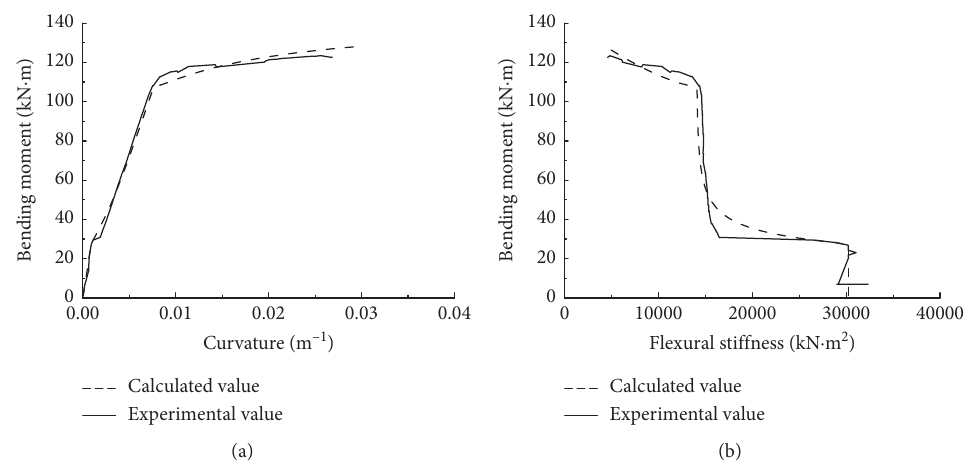
Figure 20: Beam B-1-30-8. (a) Bending moment-curvature curve. (b) Bending moment-stiffness